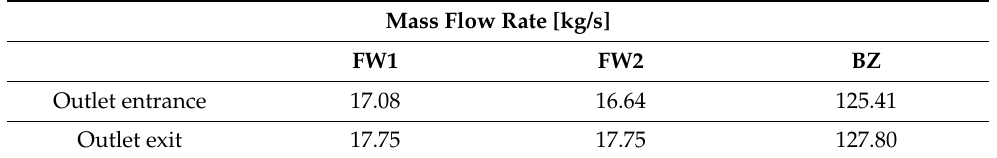
Table 1. Mass flow rates imposed as boundary conditions.